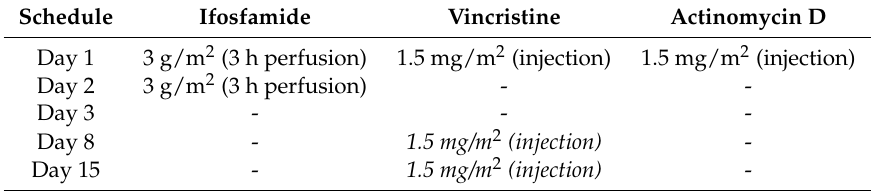
Table 1. The ifosfamide, actinomycin D, and vincristine (IVA) protocol schema. The text in italic emphasises the non mandatory part of the protocol: vincristine can be administered at day 8 and day 15 for the first two cycles. All patients from this study have been perfused with ifosfamide with the same protocol schema and for the two first cycles of chemotherapy, vincristine was also given at day 8 and day 15.